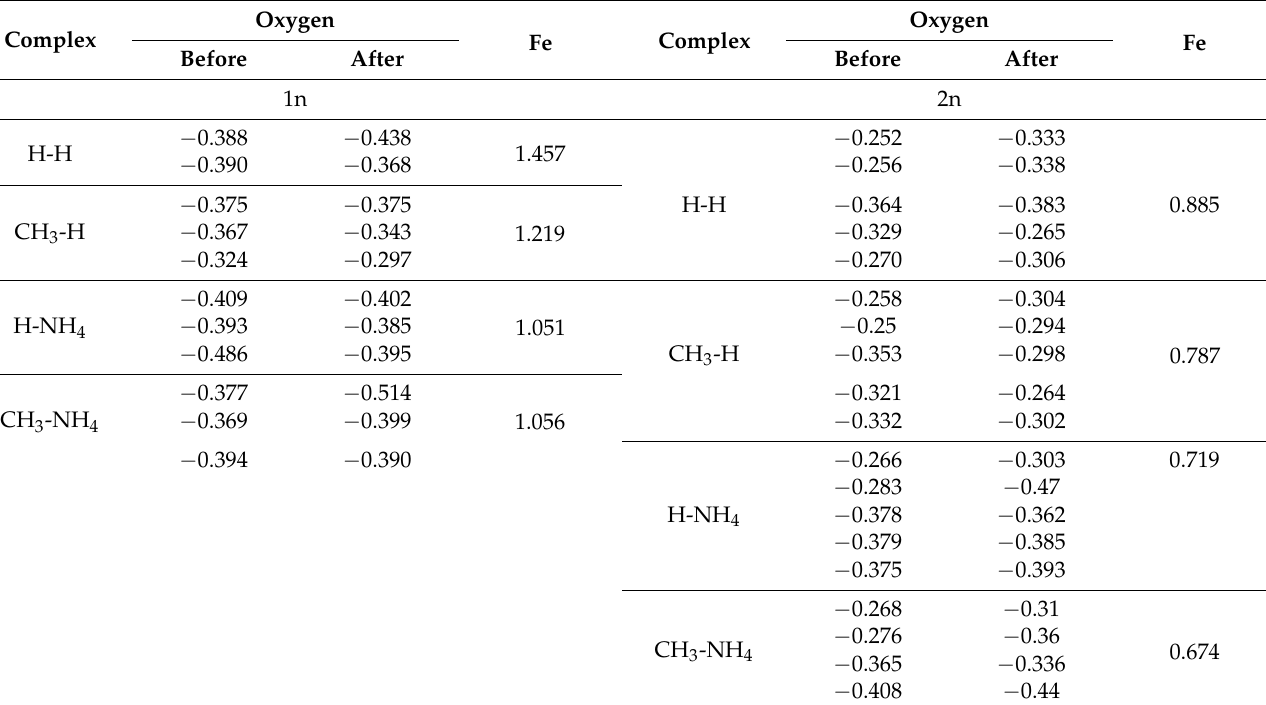
Table 4. The Mulliken charges of the oxygen atoms coordinated with Fe.